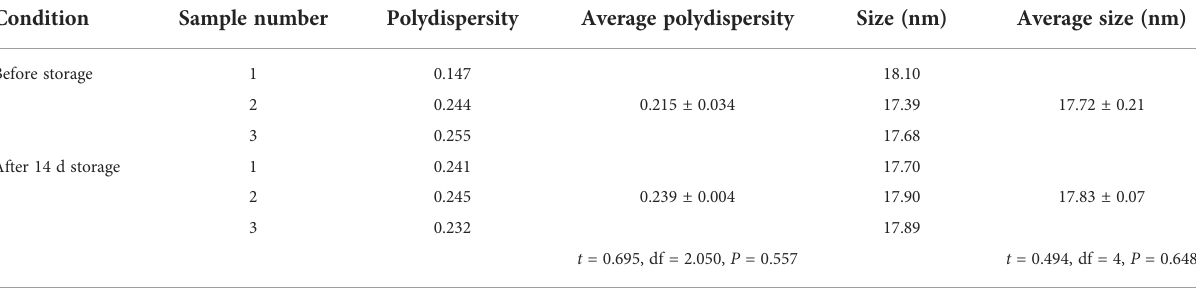
TABLE 1 Particle size and polydispersity of SPc-loaded calcium glycinate before and after the storage.